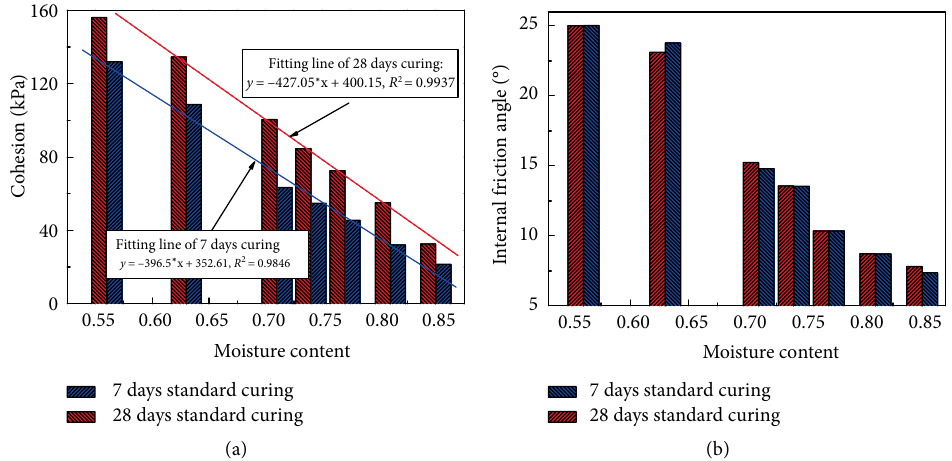
Figure 2: DST results of solidified sludge with different initial moisture contents: (a) cohesion; (b) internal friction angle.